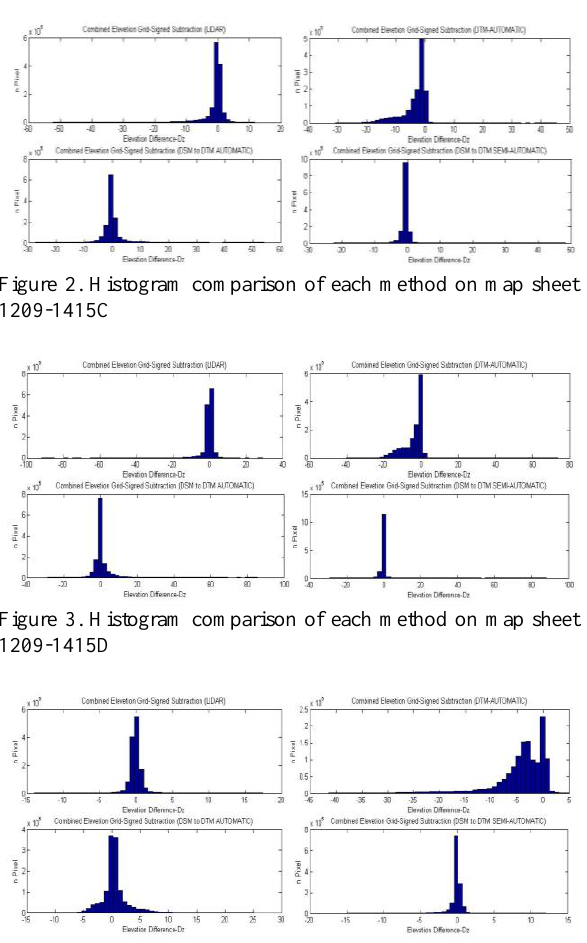
Figure 4. Histogram comparison of each method on map sheet 1209-1432C